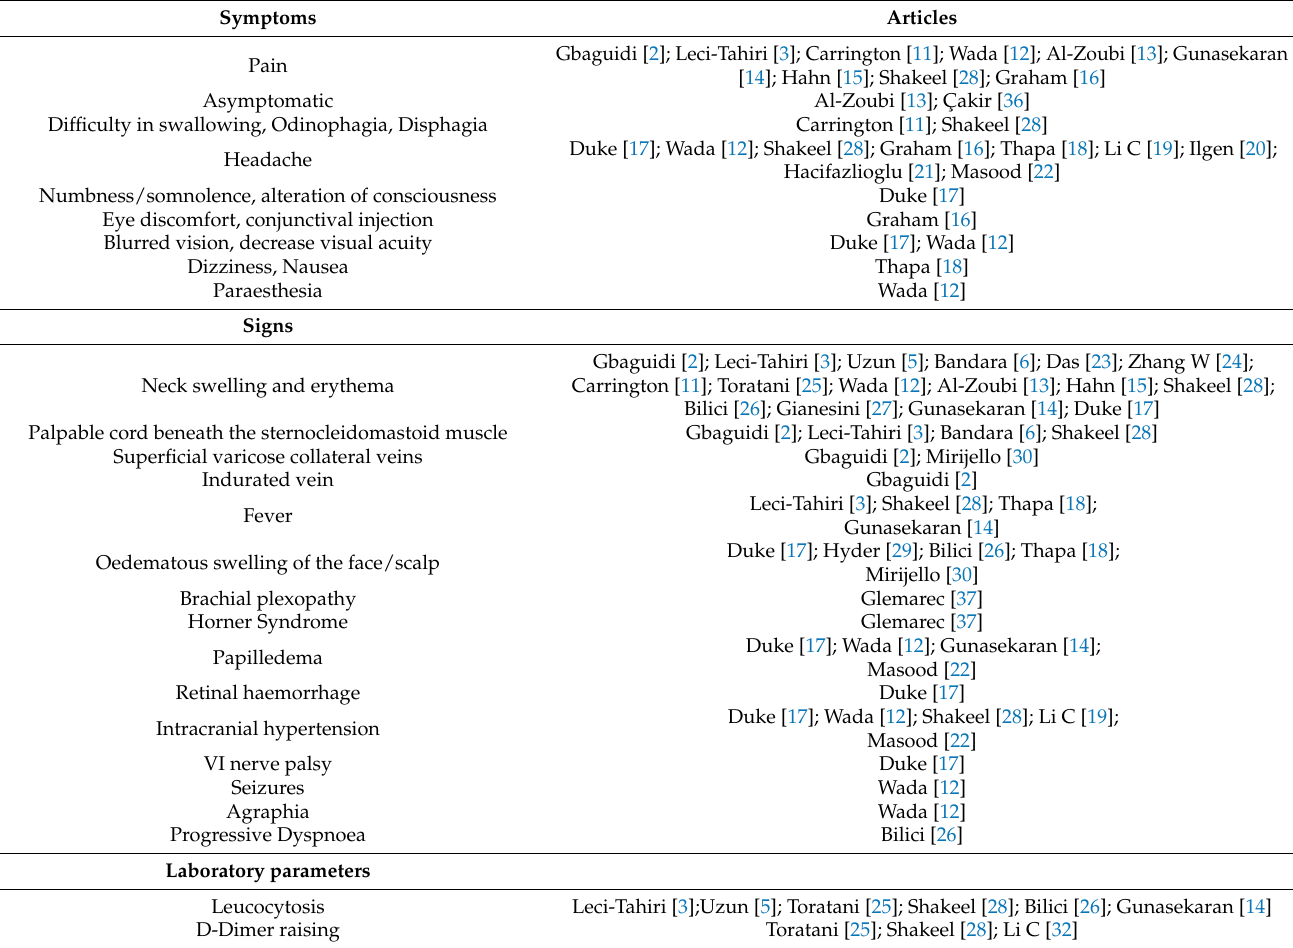
Table 1. Signs and symptoms of